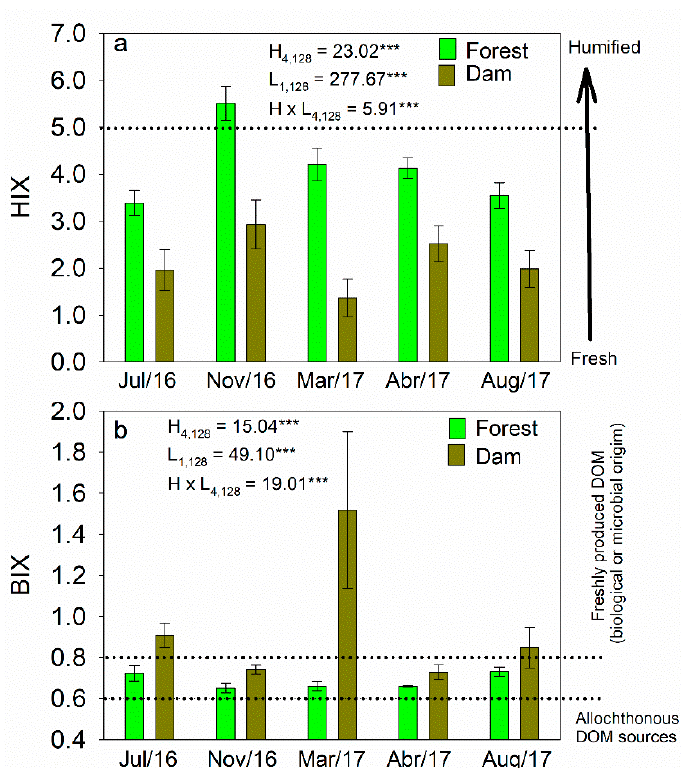
Figure 5. Mean ( ± 95% CI, n = 11 Dam; n = 15 Forest) at the research site, grouped by Dam and Forest catchments and hydrological month for ( a ) humification index (HIX) and ( b ) biological index (BIX). Statistical results are expressed using the Tamhane test of non-presumed equal variances and the probability of type I error (P) to test with land cover (L) and hydrological month (H) as fixed effects. *** p < 0.001. Dotted lines indicate threshold values for HIX and BIX for indicator values ]58].